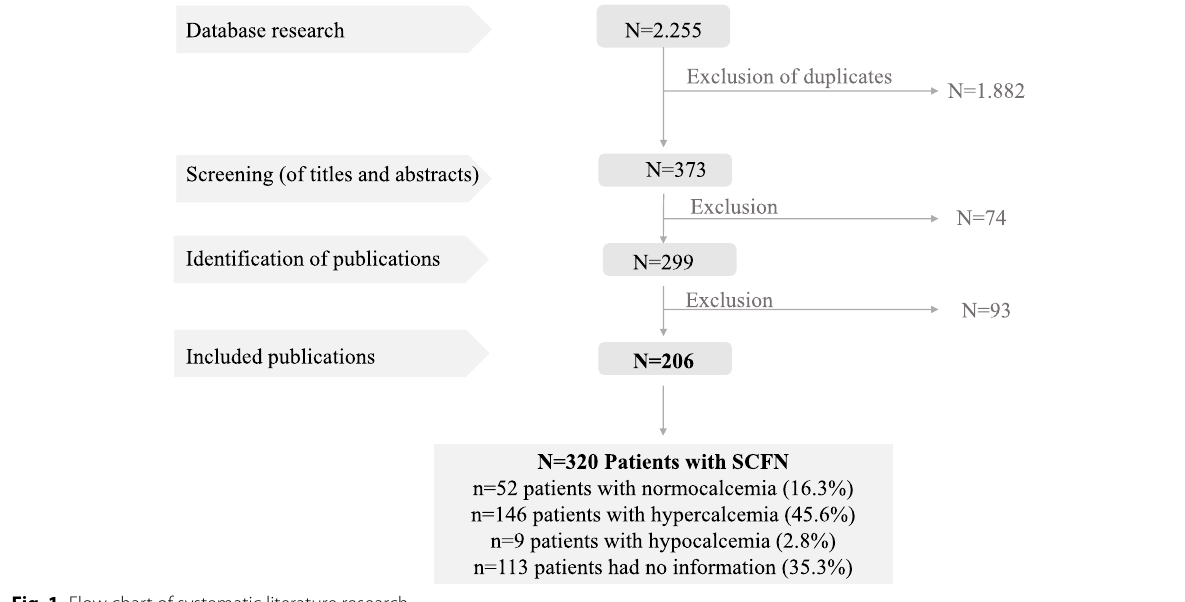
Fig. 1 Flow chart of systematic literature